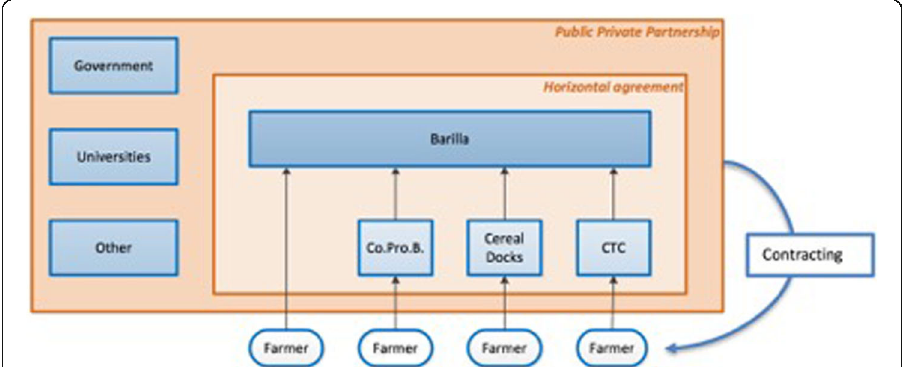
Fig. 1 Designing a MPS: the supply network of Barilla. Source: our own